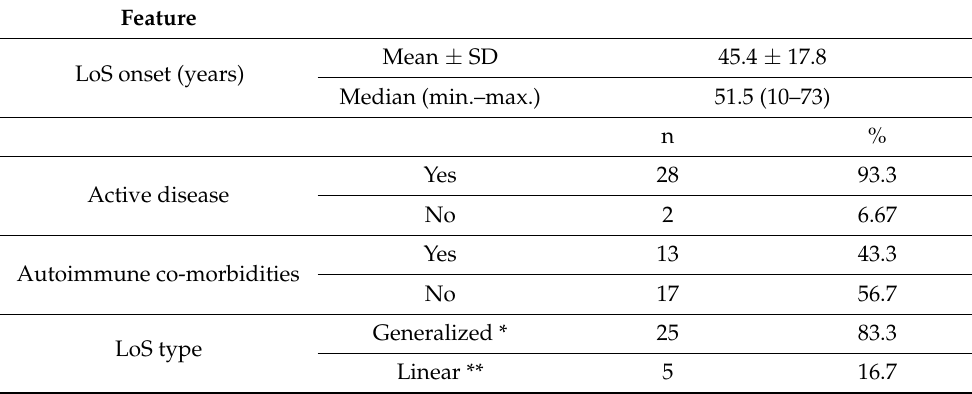
Table 3. Clinical characteristics of patients with